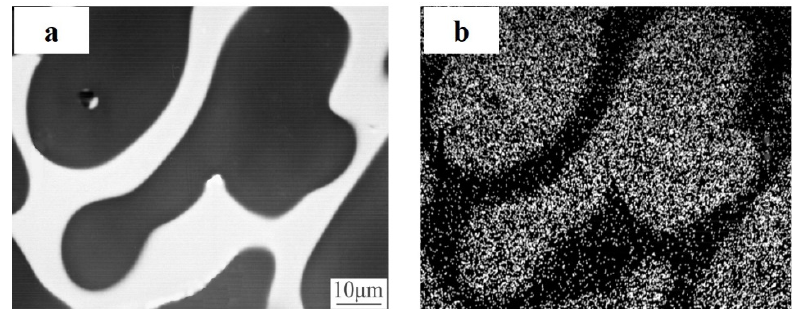
Figure 6. The m icrostructure of Be-Al alloy ( a ) and Ni element distribution ( b ). Figure 6. The microstructure of Be-Al alloy ( a ) and Ni element distribution ( b